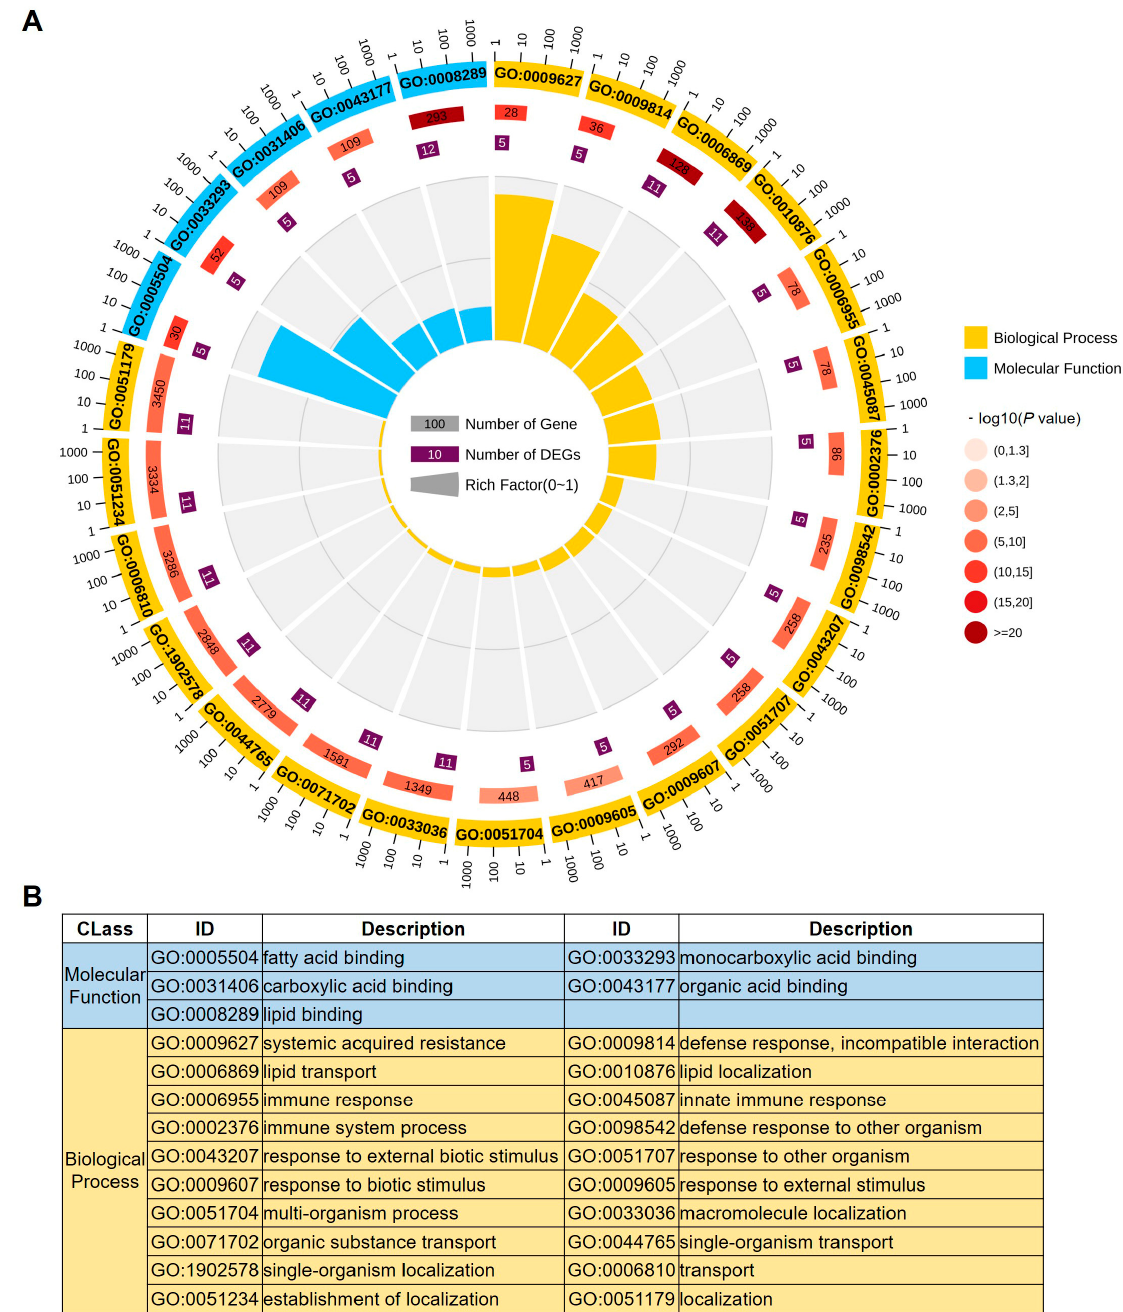
Figure 3. GO analysis of LTP genes in maize. ( A ) GO analysis, including rich factor values of each GO term, the number and P value of this GO term in background genes, and GO term of enrichment. ( B ) The ID and description of each GO term.